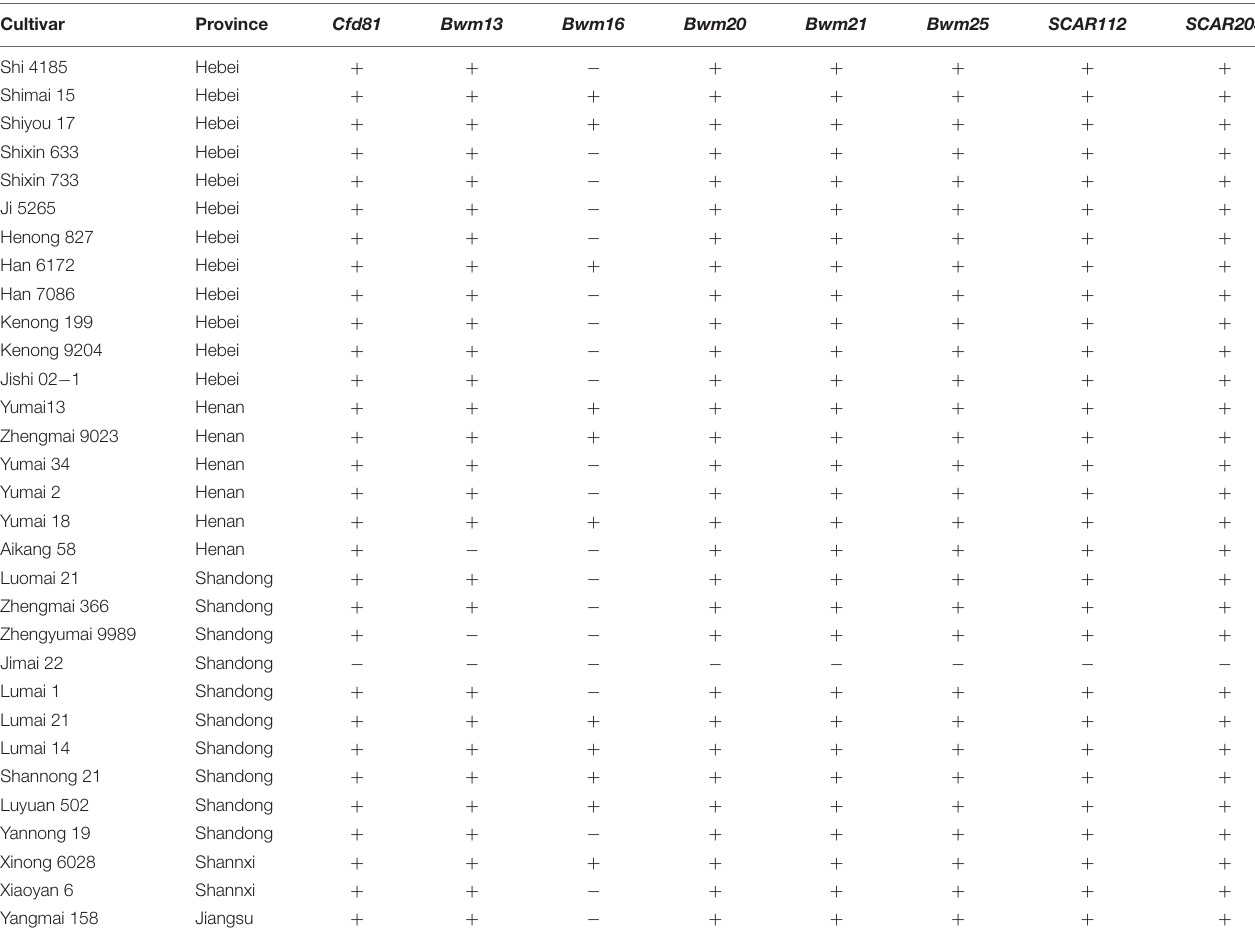
TABLE 5 | Validation of PmFG -linked SSR marker Cfd81 , SNP-derived markers Bwm13 , Bwm16 , Bwm20 , Bwm21 and Bwm25 , and SCAR markers SCAR112 and SCAR203 on 31 Chinese wheat cultivars in MAS.